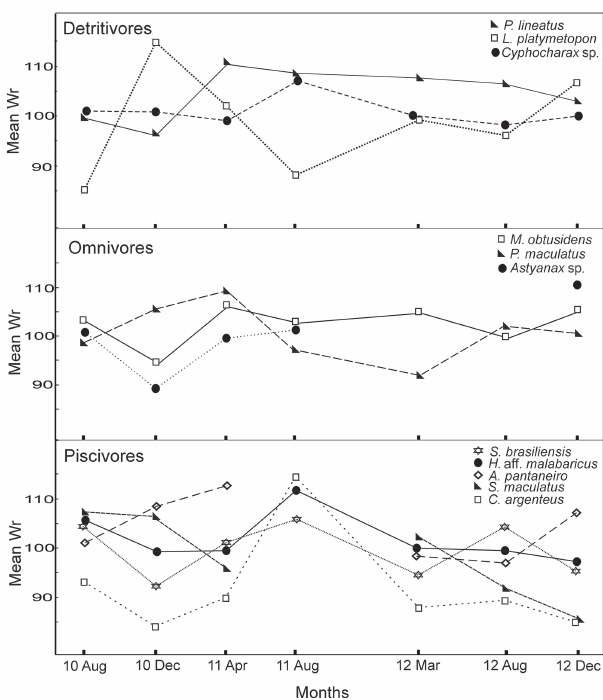
Fig. 5. Temporal variation in mean body condition of selected species for each trophic group.